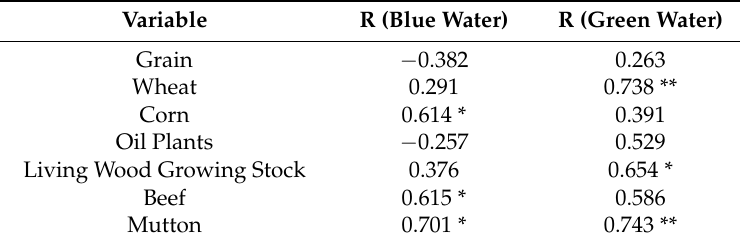
Table 1. Pearson correlation test